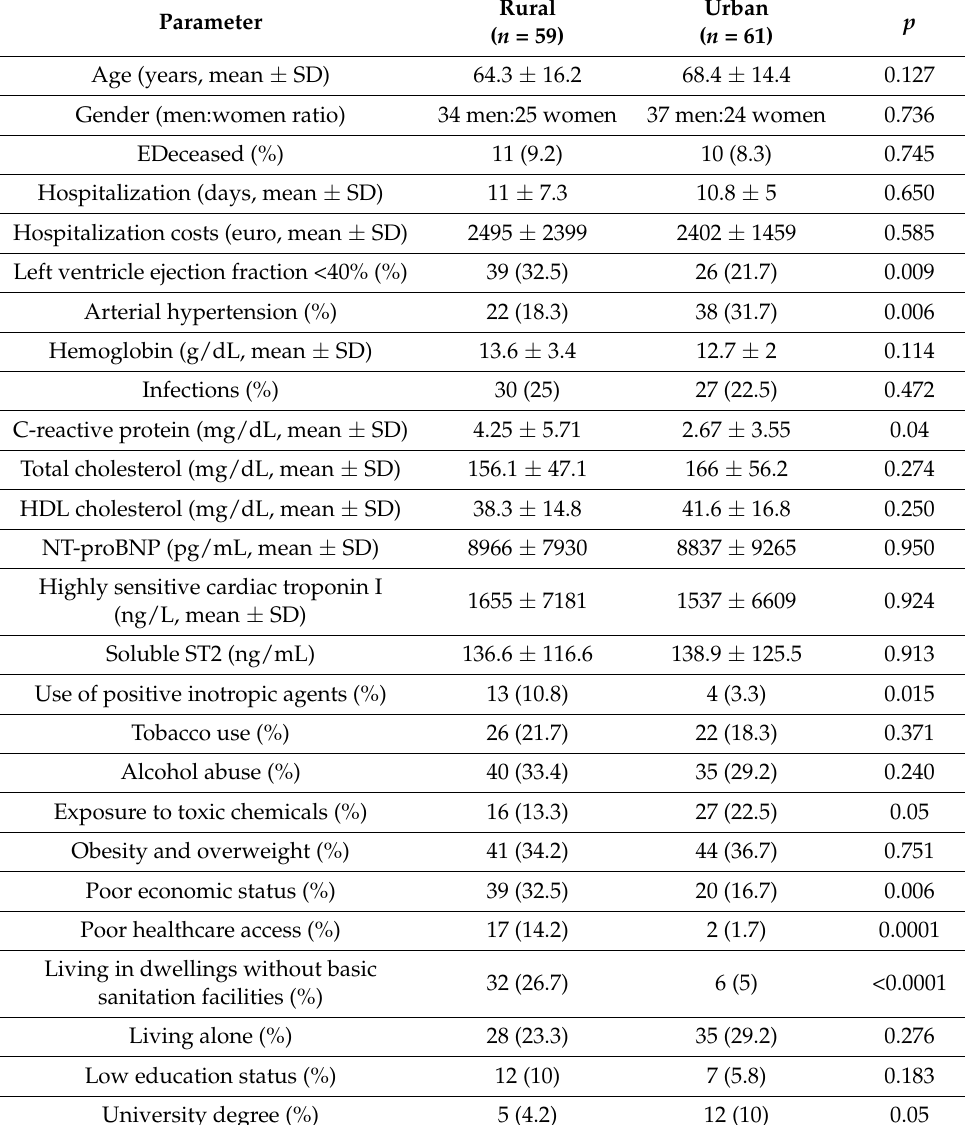
Table 2. Influence of residence on certain clinical and biological parameters in patients with